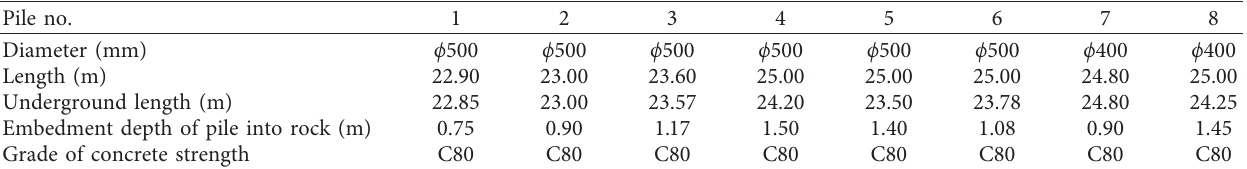
Figure 8: Field tests at soft rock bearing stratum (a) and (b) and at hard rock bearing stratum (c) and (d). (a) Pile driving (soft rock bearing stratum). (b) High-strain testing (soft rock bearing stratum). (c) Installation of sliding micrometers (hard rock bearing stratum). (d) High- strain testing (hard rock bearing stratum). Table 3: Characteristics of test piles at the soft rock bearing stratum